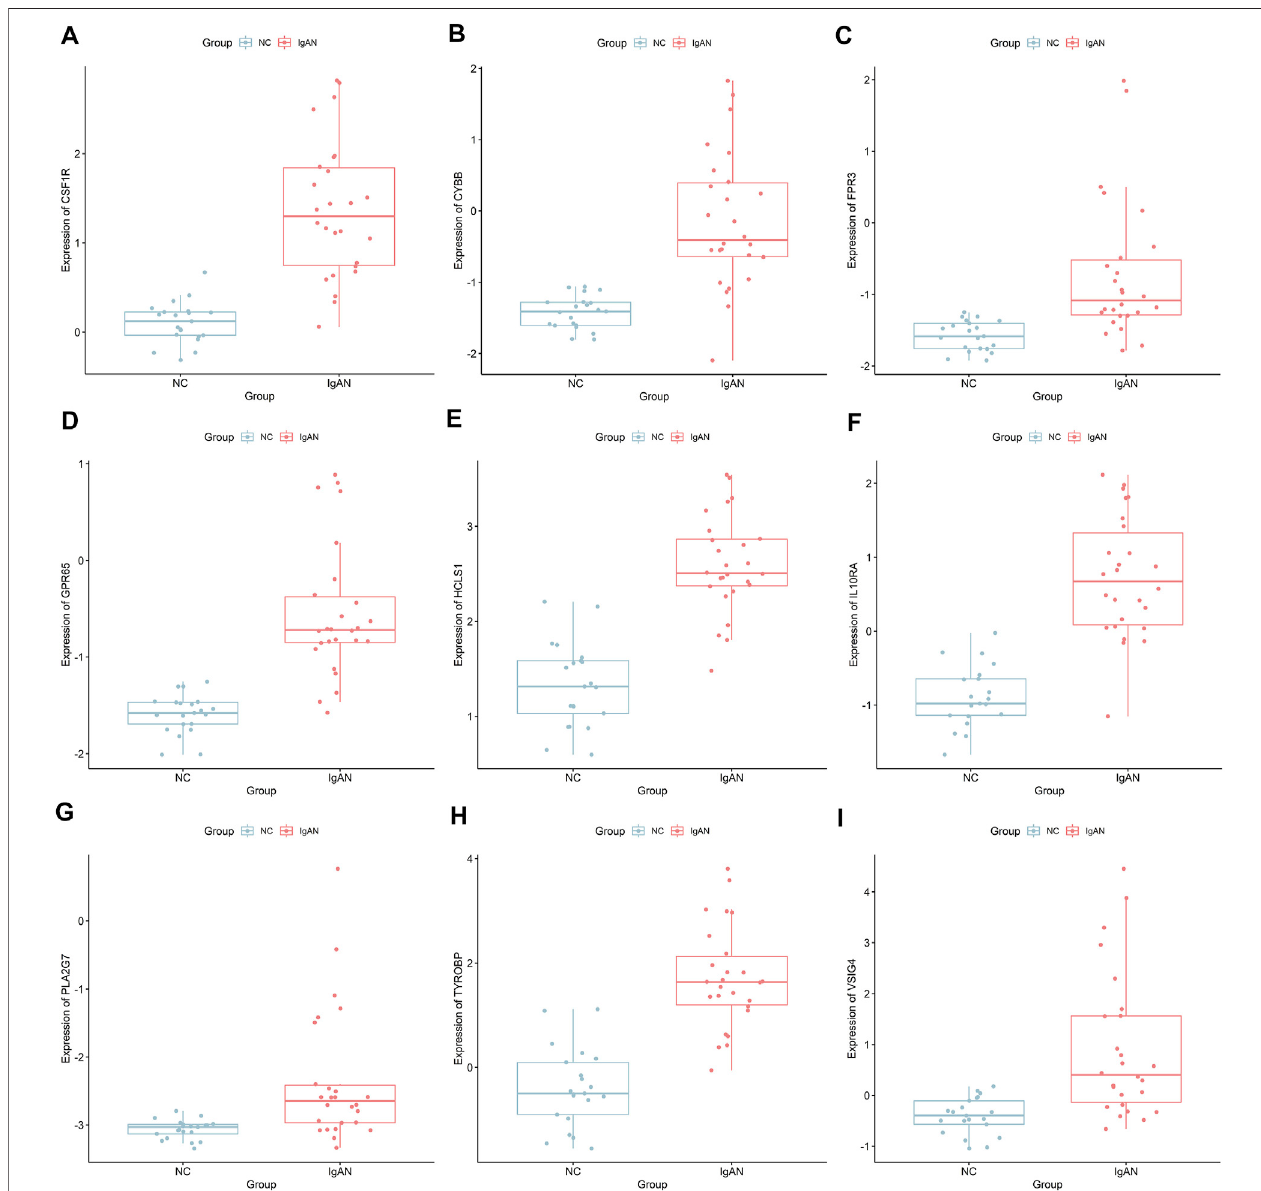
FIGURE 7 | Differential expression of the nine real hub genes between IgAN and normal control in the external dataset. (A – I) Differential expression of CSF1R, CYBB, FPR3, GPR65, HCLS1, IL10RA, PLA2G7, TYROBP, and VSIG4 in the external dataset.